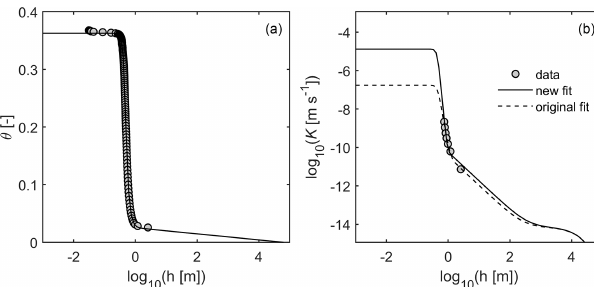
Figure 8. Same data as in Fig. 1c and d. A new scheme with vGmn as basic retention function and τ s fixed at 0.094 was fitted to the data (new fit). For comparison, the original fit using K s as adjustable parameter is given by dashed lines. Note that the new scheme has one adjustable parameter less.